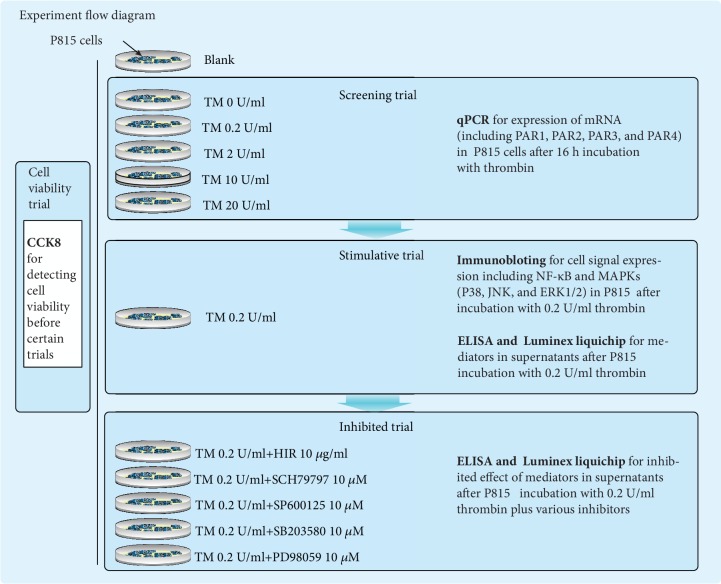
Cell experiment flow diagram. TM: thrombin; HIR: hirudin; SCH79797: PAR1 inhibitor; SP600125: JNK inhibitor; SB203580: P38 MEPK inhibitor; PD98059: ERK1/2 MAPK inhibitor; qPCR: quantitative real-time PCR; ELISA: enzyme-linked immunosorbent assay. Screening trial for deciding the fittest concentration of thrombin. Stimulative trial: thrombin 0.2 U/ml was used to stimulate P815 cells. Inhibited trial: thrombin 0.2 U/ml plus different inhibitors were used to stimulate P815 cells. Blank: P815 cells were cultured in normal condition with no challenge. We chose thrombin 0.2 U/ml as the fittest concentration by screening trial. All challenges underwent pretrial by CCK8 to exclude the interference of P815 cell death.